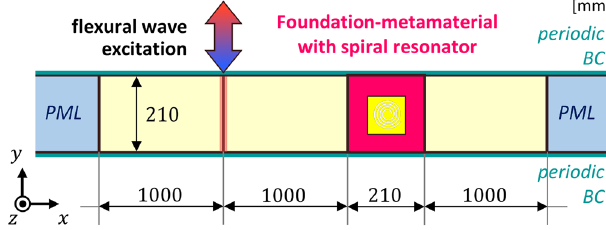
Figure 11. Setup for wave simulations in the frequency